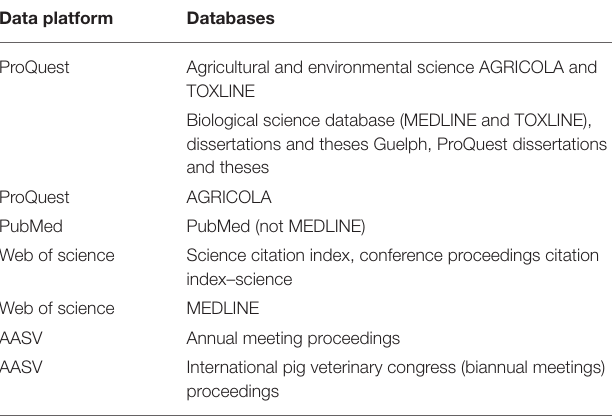
TABLE 1 | Data platform and database information sources used in the scoping review search on non-antibiotic approaches to reduce the need for antibiotics in nursery pig